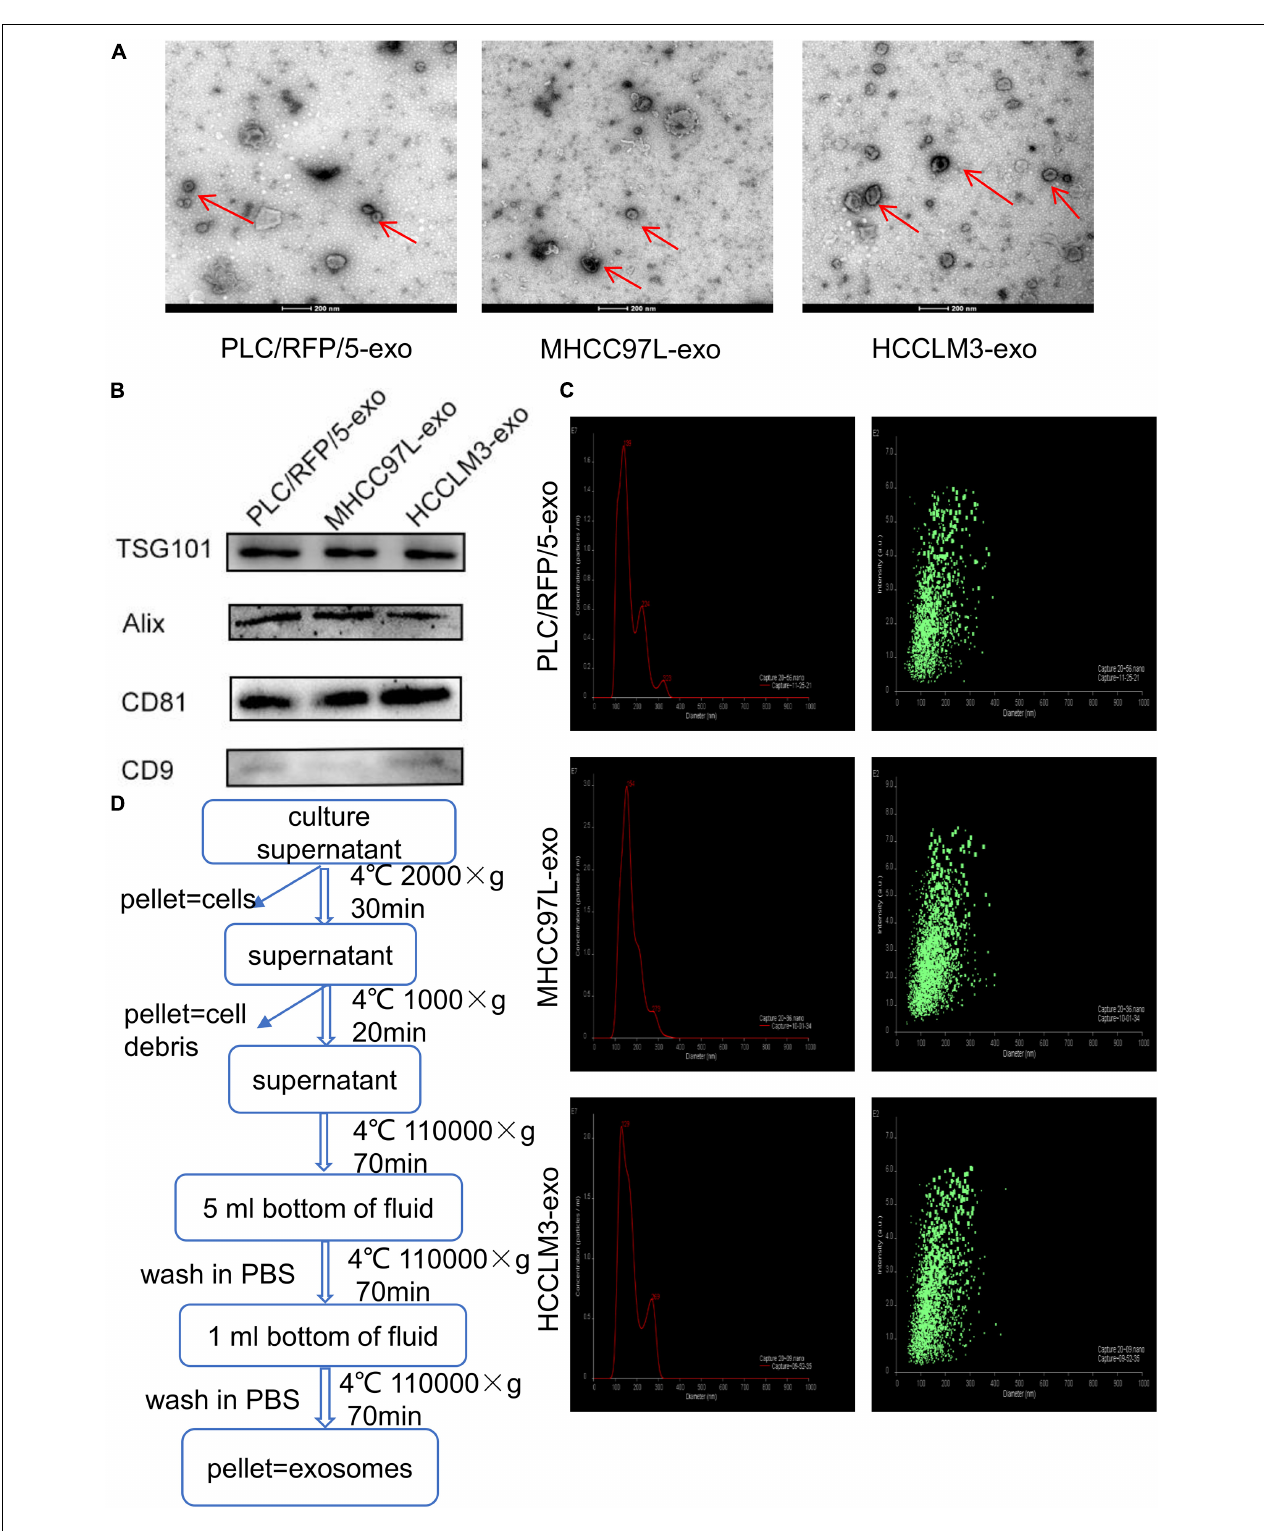
FIGURE 1 | Characterization of exosomes derived from liver cancer cells. (A) Transmission electron microscopy analysis of exosomes (Exos) derived from HCC cell lines (HCCLM3, MHCC97L, and PLC/RFP/5). Scale bar, 200 nm. (B) Immunoblotting assay of exosomal biomarkers in different liver cancer cells. (C) Mean diameter and size distribution of HCC-Exos was detected by Nanoparticle tracking analysis. (D) Strategy for exosomes purifcation from the HCC cell lines culture supernatants based on differential centrifugations.